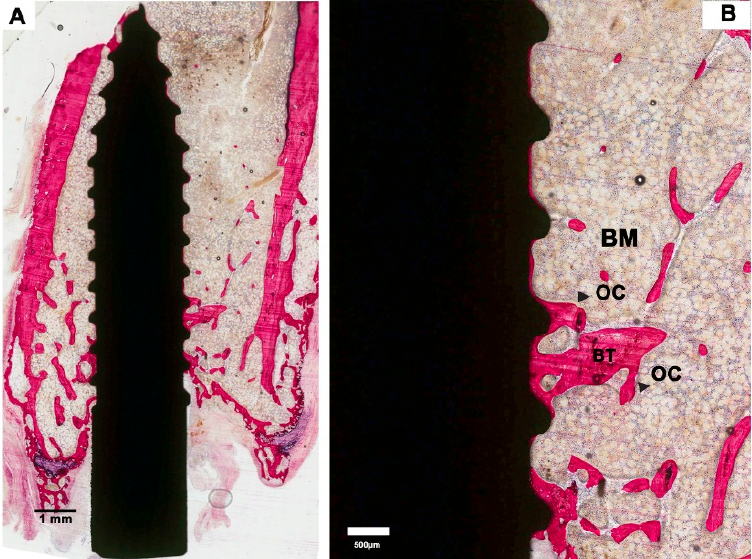
Figure 2. Histological sections of an implant in the saline group (control). ( A ). Low-magnification image showing a limited amount of bone formation. ( B ). Representative histological images at higher magnification showing osteoclast-like cells (OC) on the surface of the bone trabeculae (BT). Bone marrow (BM) was present between the bone trabeculae and in the areas where bone was lacking. Between the tips of the screw threads, a thin layer of bone is visible on the implant surface.